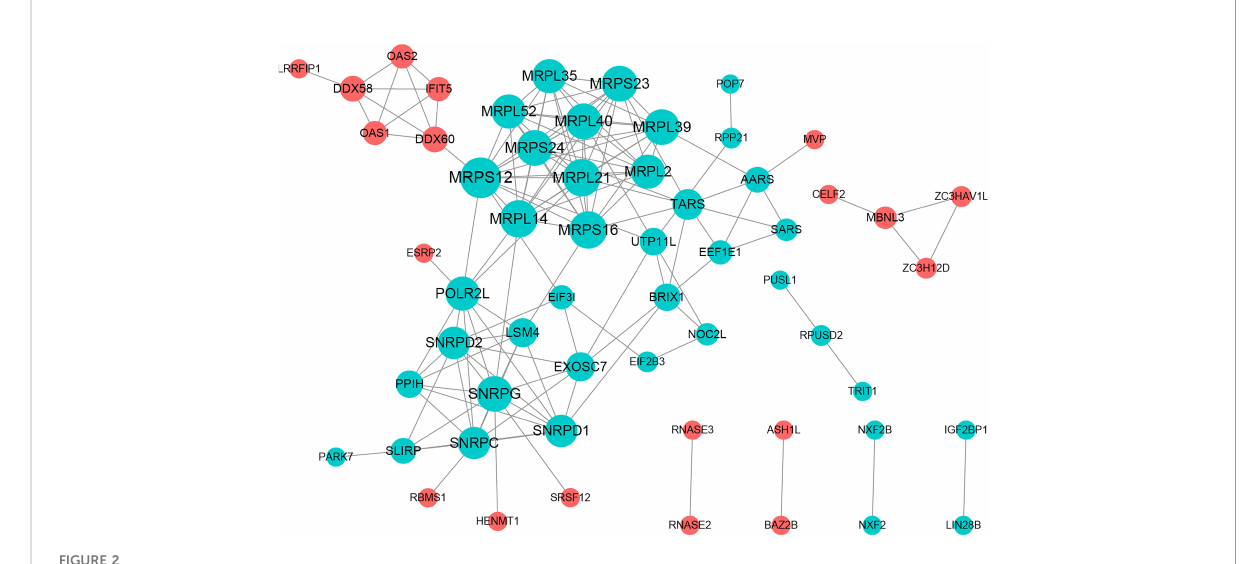
FIGURE 2 Protein-protein interactions (PPI) network constructed with PRBP-DEGs by STRING.